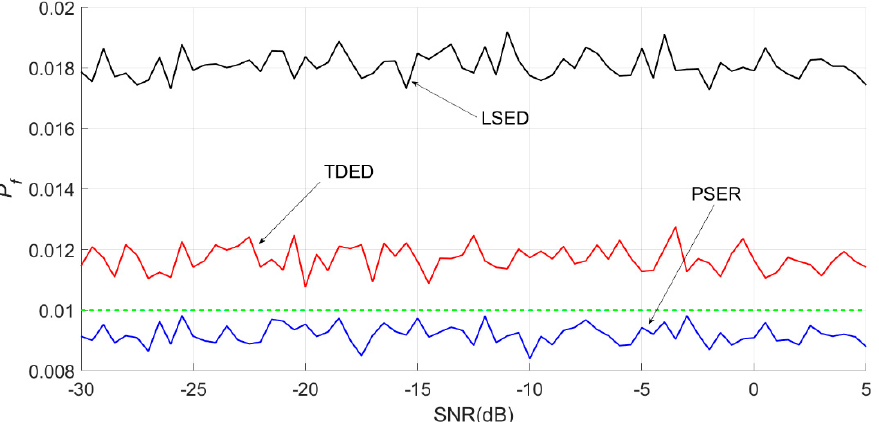
Figure 11. Actual false alarm probabilities obtained by three methods for narrow-band signals when N = 512 and d = 22. The green dotted line is the pre-set theoretical false alarm probability.